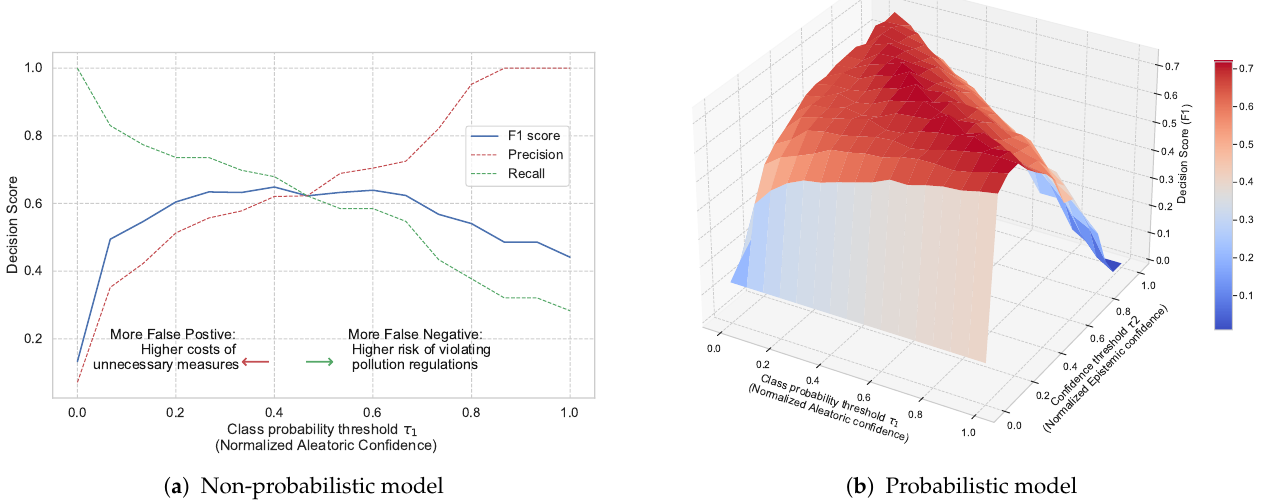
Figure 30. Comparison of decision score in non-probabilistic and probabilistic models. ( a ) Decision score in a non- probabilistic model as a function of class probability threshold ( τ 1 corresponding to aleatoric confidence). ( b ) Decision score in a probabilistic model as a function of both class probability threshold ( τ 1 ) and model confidence threshold ( τ 2 corresponding to epistemic